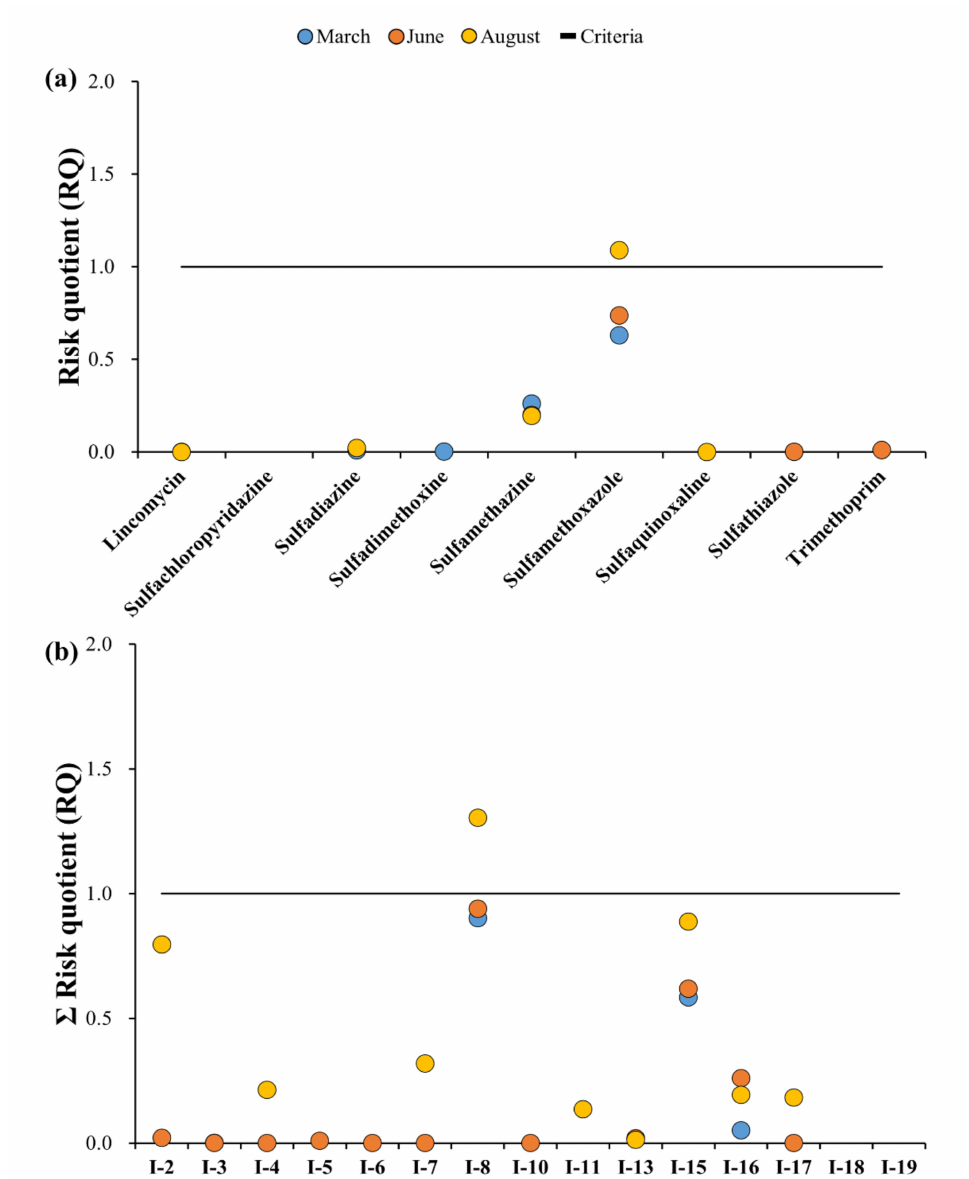
Figure 8. Ecological risk assessment of target antibiotics: ( a ) Risk quotient for each sampling cam- paign for each antibiotic. ( b ) RQ of each sampling campaign at each sampling point for groundwater; Blue circle: March, Orange circle: June, Yellow: August, Grey: December, Solid line: Criteria (RQ =